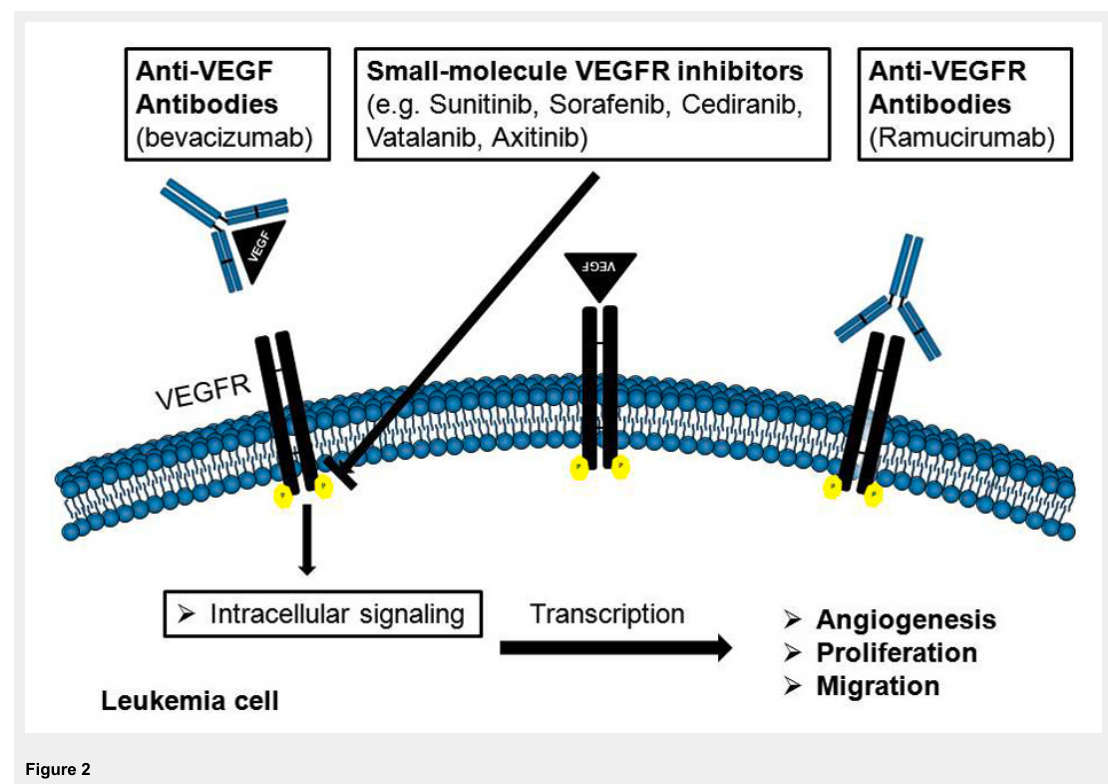
Figure 2 Mechanisms of action of angiogenic inhibitors in leukaemia. VEGF = vascular endothelial growth factor VEGFR = vascular endothelial growth factor